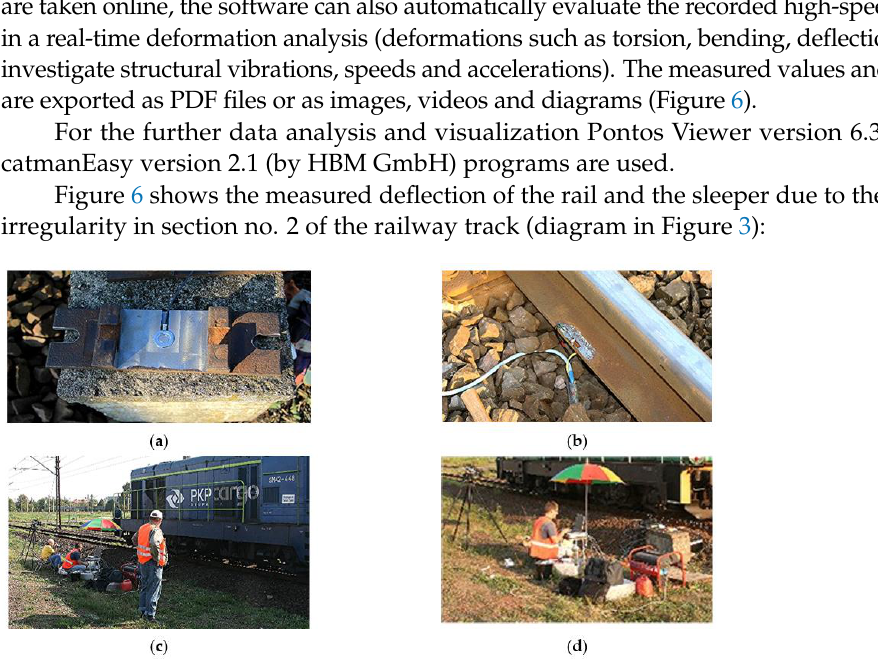
Figure 5. Field investigations at the Poznan-Franowo station [author’s photos]: ( a ) the KMR200 HBM indicator placed on the sole plate to measure the force transferred from the rail to the railway sleeper; ( b ) the extensometer LY41-20/120 on the rail foot for direct stress measurement; ( c ) the measuring position for recording the obtained measurements (a locomotive’s SM -48 ride); ( d ) the measured points for recording obtained measurements (the Pontos system).